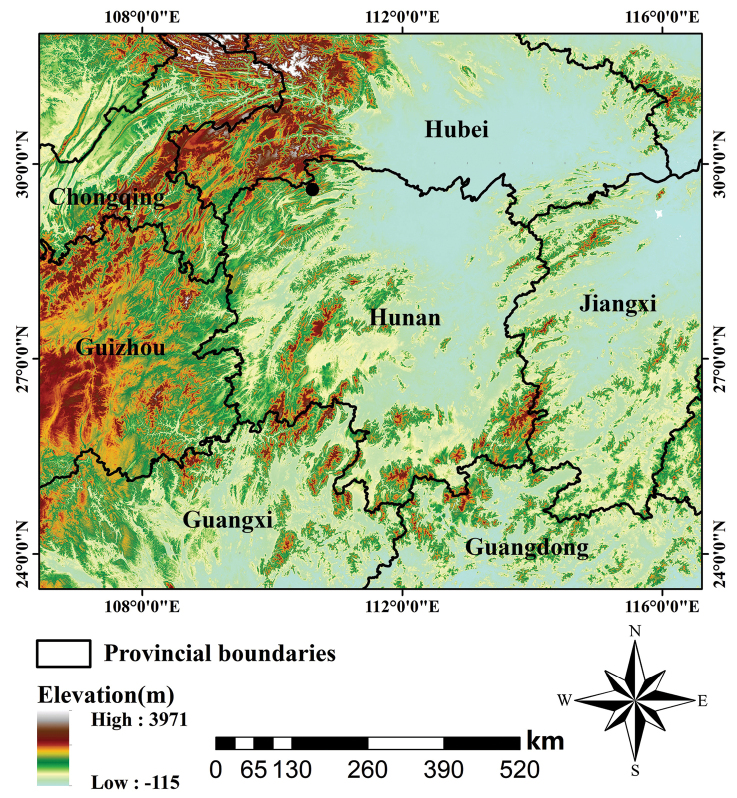
Collection location of Odorrana
sangzhiensis sp. nov. from Sangzhi County, Hunan Province, China, indicated by a black dot.